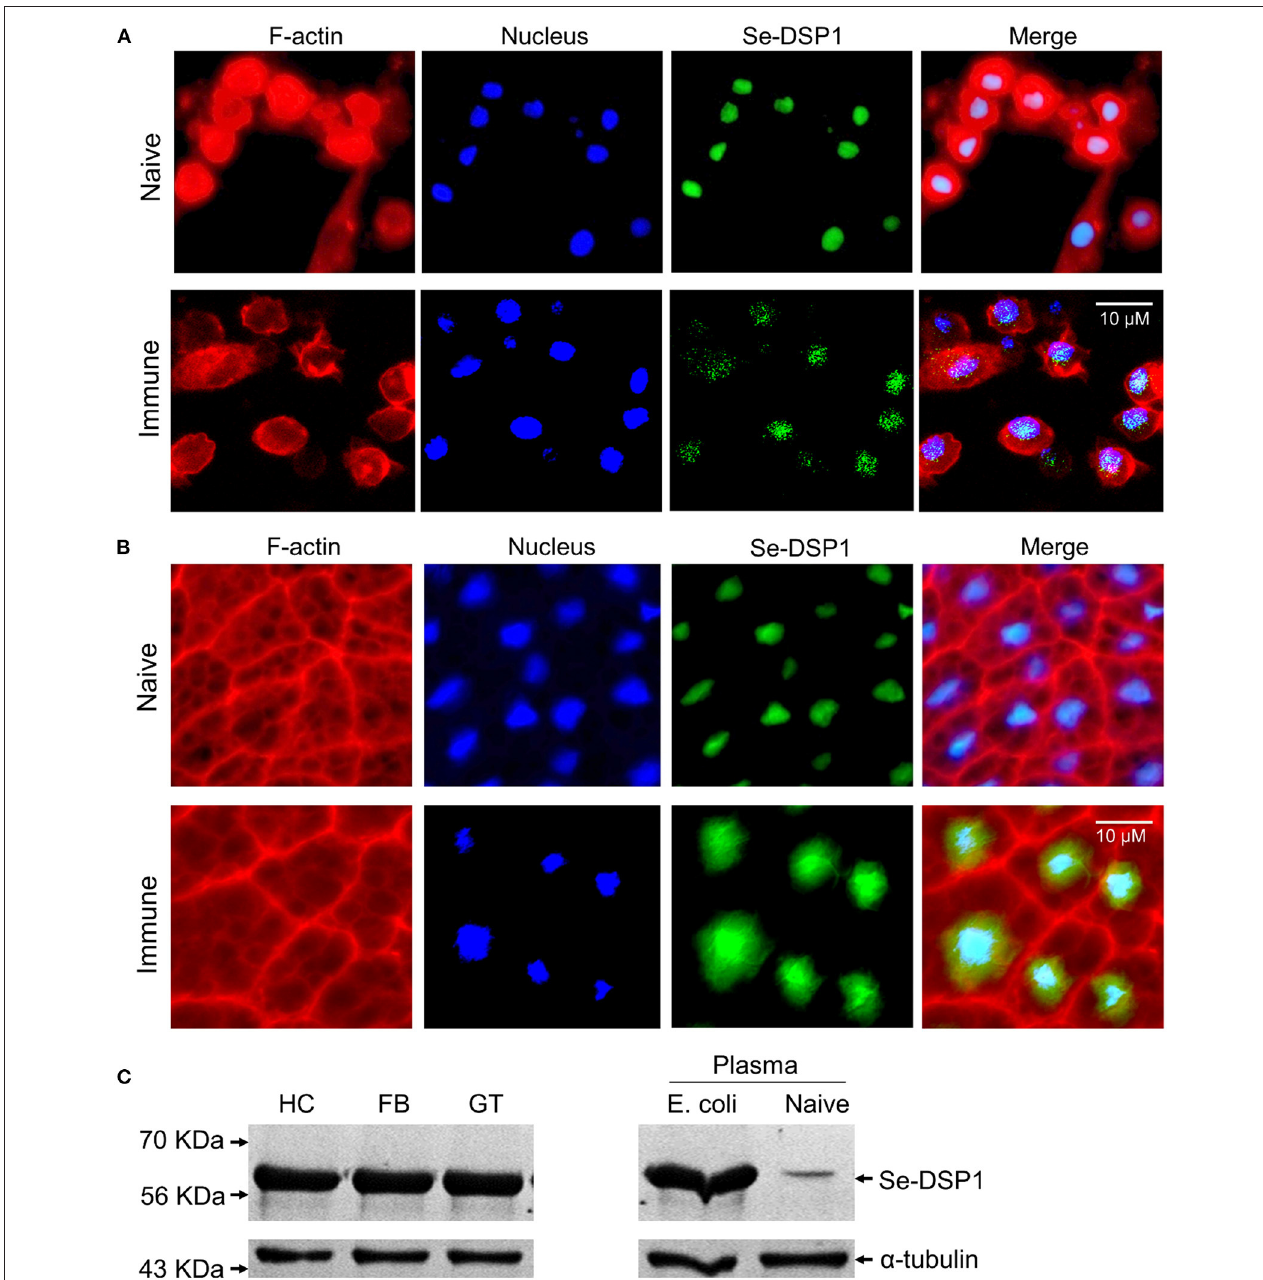
FIGURE 1 | The release of dorsal switch protein 1 (DSP1) Spodoptera exigua (Se-DSP1) proteins from nuclei in response to an immune challenge. (A) The mobilization of Se-DSP1 in hemocytes. (B) The mobilization of Se-DSP1 in the fat body. Cytosol and nuclei were stained with phalloidin against F-actin and 4 ′ ,6-diamidino-2-phenylindole (DAPI) against nuclear DNA. Se-DSP1 was detected with a polyclonal antibody raised against mammalian high mobility group box 1 (HMGB1). Supplementary Table S3 describes the setting values of the fluorescence microscope to get the immunofluorescence images. (C) Western blotting against different tissue proteins of hemocyte (“HC”), fat body (“FB”), and midgut (“GT”). For the immune challenge, each of the L5 larvae were injected with 4.5 × 10 4 heat-killed (HK) Escherichia coli cells. Plasma samples were collected 6h post injection (PI). A homogenous immunoblotting intensity against α -tubulin indicates the equal amount of protein sample loading in each lane.